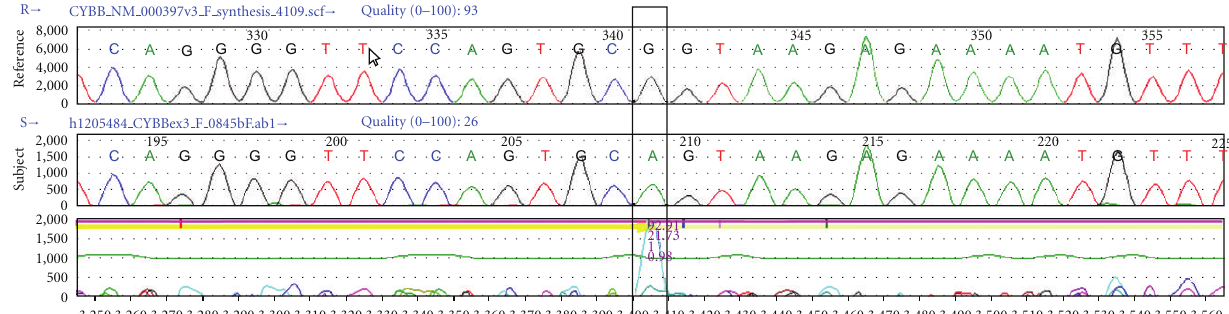
Figure 5: Genomic DNA sequence of the proband gp-91-phox transcript. Sanger sequencing of a normal CYBB gene (reference) and the patient (subject) showing c.252 G > A mutation of an alanine codon (GCG to GCA), followed by a classic splice donor signal GTAAG in the intron (lower